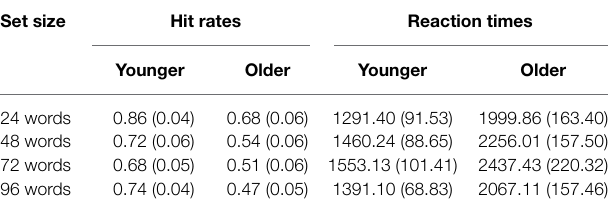
TABLE 3 | Accuracy and RTs for the color-assignment task. Set